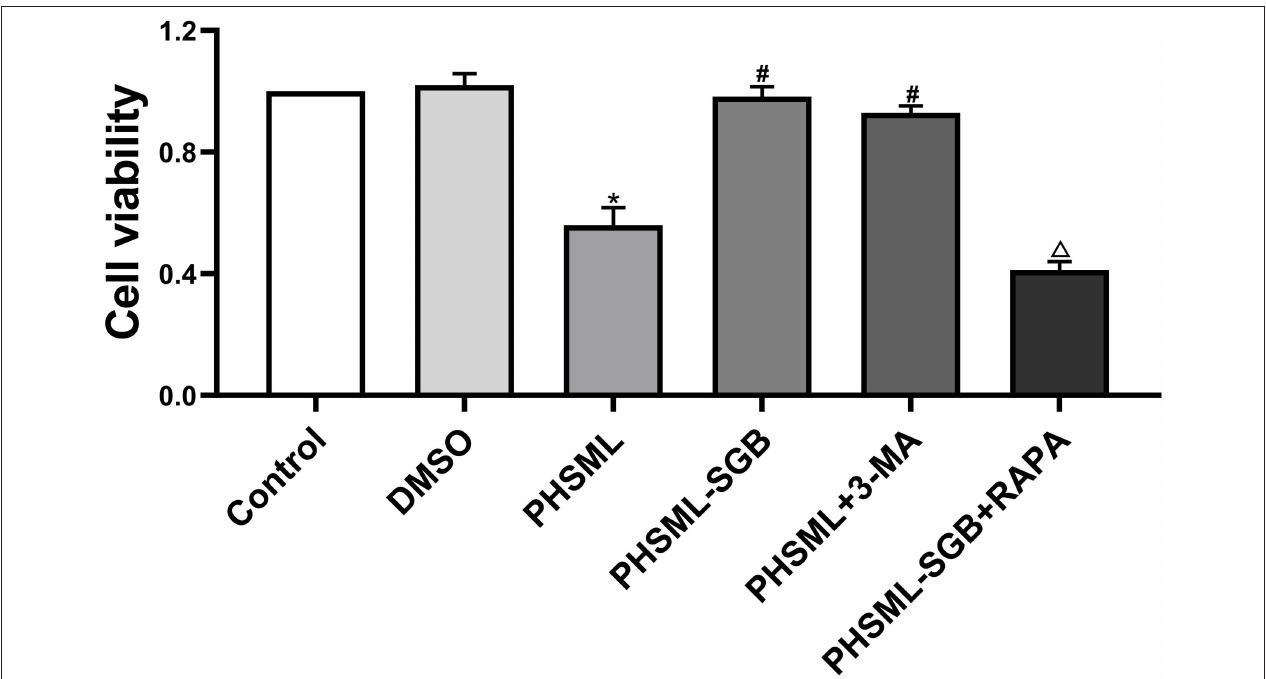
FIGURE 3 | Effect of SGB and autophagy drugs on the viability of vascular smooth muscle cells (VSMCs) injured by PHSML. The cells were treated with PHSML (4%), PHSML-SGB (PHSML obtained from the rats underwent hemorrhagic shock plus SGB treatment, 4%), PHSML plus 3-MA (autophagy inhibitor, 5mM), and PHSML-SGB plus Rapa (autophagy activator, 100nM) for 6h, respectively. The cell viability was detected by the Cell Counting Kit-8 (CCK-8) method. The data are presented as mean ± SEM ( n = 6). Differences among groups were analyzed using the one-way ANOVA and the post hoc test with the SNK test. * P < 0.05 compared with the control group; # P < 0.05 compared with the PHSML group; 1 P < 0.05 compared with the PHSML-SGB group.